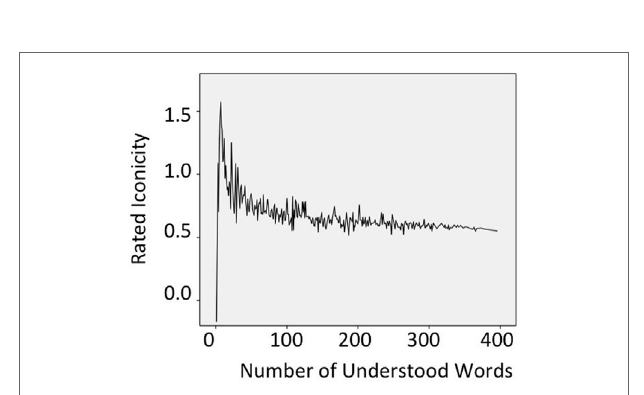
FigUre 5 | average rated iconicity of the words that a child produced as a function of the frequency of occurrence of the number of words the child produced .